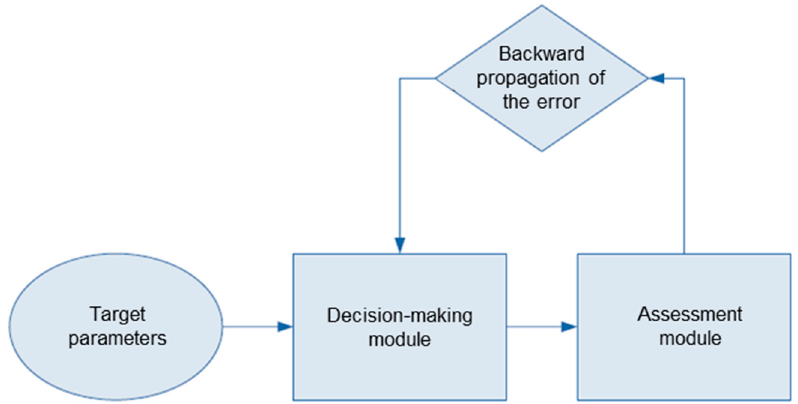
Figure 4. Decision-making module training.